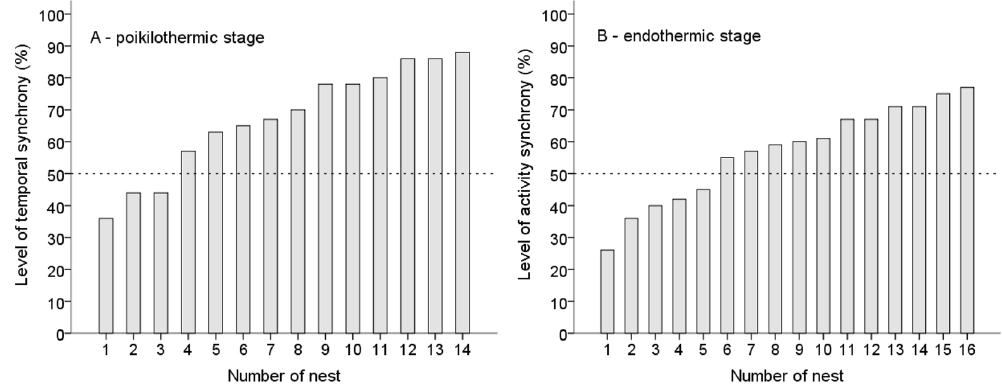
Figure 1. Behavioural synchronisation of Blackcap parents. ( A ) Temporal synchronisation during the poikilothermic nestling stage, n = 14 nests; ( B ) Activity synchronisation during the endothermic nestling stage, n = 16 nests. The level of synchronicity was presented for each studied nest. Nests were ranked from lowest to highest level of synchronicity. The dotted line indicates that two-thirds of pairs synchronised over 50% of feeding